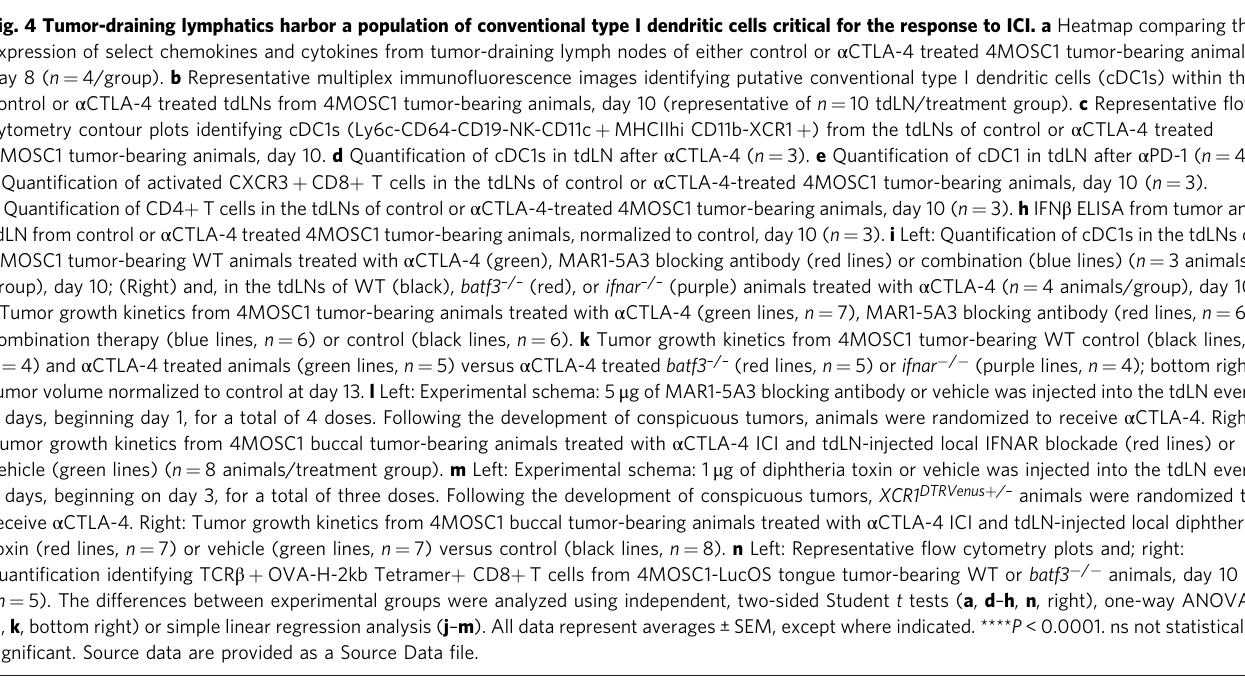
Fig. 4 Tumor-draining lymphatics harbor a population of conventional type I dendritic cells critical for the response to ICI. a Heatmap comparing the expression of select chemokines and cytokines from tumor-draining lymph nodes of either control or α CTLA-4 treated 4MOSC1 tumor-bearing animals, day 8 ( n = 4/group). b Representative multiplex immuno fl uorescence images identifying putative conventional type I dendritic cells (cDC1s) within the control or α CTLA-4 treated tdLNs from 4MOSC1 tumor-bearing animals, day 10 (representative of n = 10 tdLN/treatment group). c Representative fl ow cytometry contour plots identifying cDC1s (Ly6c-CD64-CD19-NK-CD11c + MHCIIhi CD11b-XCR1 + ) from the tdLNs of control or α CTLA-4 treated 4MOSC1 tumor-bearing animals, day 10. d Quanti fi cation of cDC1s in tdLN after α CTLA-4 ( n = 3). e Quanti fi cation of cDC1 in tdLN after α PD-1 ( n = 4). f Quanti fi cation of activated CXCR3 + CD8 + T cells in the tdLNs of control or α CTLA-4-treated 4MOSC1 tumor-bearing animals, day 10 ( n = 3). g Quanti fi cation of CD4 + T cells in the tdLNs of control or α CTLA-4-treated 4MOSC1 tumor-bearing animals, day 10 ( n = 3). h IFN β ELISA from tumor and tdLN from control or α CTLA-4 treated 4MOSC1 tumor-bearing animals, normalized to control, day 10 ( n = 3). i Left: Quanti fi cation of cDC1s in the tdLNs of 4MOSC1 tumor-bearing WT animals treated with α CTLA-4 (green), MAR1-5A3 blocking antibody (red lines) or combination (blue lines) ( n = 3 animals/ group), day 10; (Right) and, in the tdLNs of WT (black), batf3 – / – (red), or ifnar – / – (purple) animals treated with α CTLA-4 ( n = 4 animals/group), day 10. j Tumor growth kinetics from 4MOSC1 tumor-bearing animals treated with α CTLA-4 (green lines, n = 7), MAR1-5A3 blocking antibody (red lines, n = 6), combination therapy (blue lines, n = 6) or control (black lines, n = 6). k Tumor growth kinetics from 4MOSC1 tumor-bearing WT control (black lines, n = 4) and α CTLA-4 treated animals (green lines, n = 5) versus α CTLA-4 treated batf3 – / – (red lines, n = 5) or ifnar − / − (purple lines, n = 4); bottom right: tumor volume normalized to control at day 13. l Left: Experimental schema: 5 μ g of MAR1-5A3 blocking antibody or vehicle was injected into the tdLN every 2 days, beginning day 1, for a total of 4 doses. Following the development of conspicuous tumors, animals were randomized to receive α CTLA-4. Right: Tumor growth kinetics from 4MOSC1 buccal tumor-bearing animals treated with α CTLA-4 ICI and tdLN-injected local IFNAR blockade (red lines) or vehicle (green lines) ( n = 8 animals/treatment group). m Left: Experimental schema: 1 μ g of diphtheria toxin or vehicle was injected into the tdLN every 3 days, beginning on day 3, for a total of three doses. Following the development of conspicuous tumors, XCR1 DTRVenus + / – animals were randomized to receive α CTLA-4. Right: Tumor growth kinetics from 4MOSC1 buccal tumor-bearing animals treated with α CTLA-4 ICI and tdLN-injected local diphtheria toxin (red lines, n = 7) or vehicle (green lines, n = 7) versus control (black lines, n = 8). n Left: Representative fl ow cytometry plots and; right: quanti fi cation identifying TCR β + OVA-H-2kb Tetramer + CD8 + T cells from 4MOSC1-LucOS tongue tumor-bearing WT or batf3 − / − animals, day 10 ( n = 5). The differences between experimental groups were analyzed using independent, two-sided Student t tests ( a , d – h , n , right), one-way ANOVA ( i , k , bottom right) or simple linear regression analysis ( j – m ). All data represent averages ± SEM, except where indicated. **** P < 0.0001. ns not statistically signi fi cant. Source data are provided as a Source Data fi